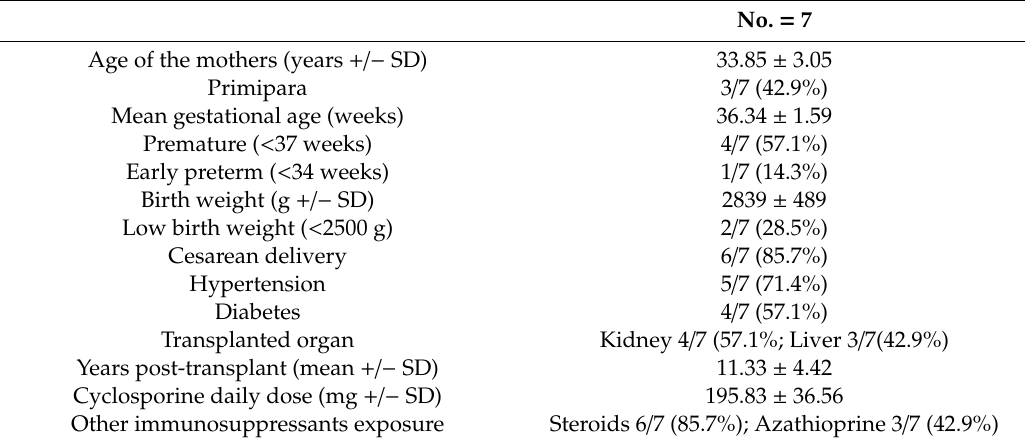
Table 1. Characteristics of the study